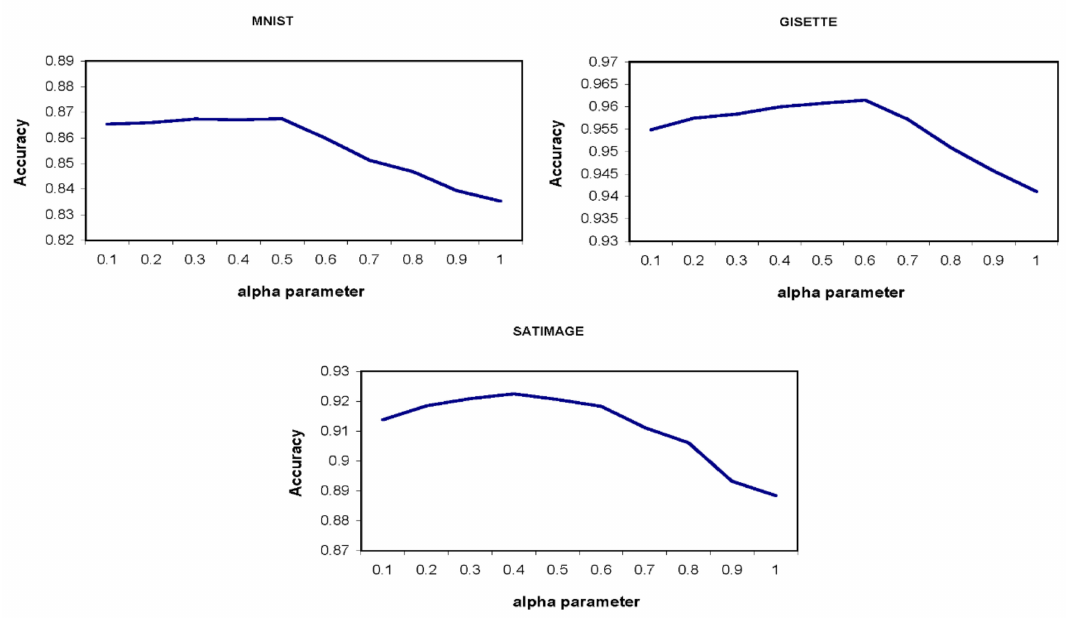
Figure 3. Classification accuracy of the proposed approach for di ff erent values of the α parameter. As it can be seen, the proposed approach has a better performance for the value of 0.5 on